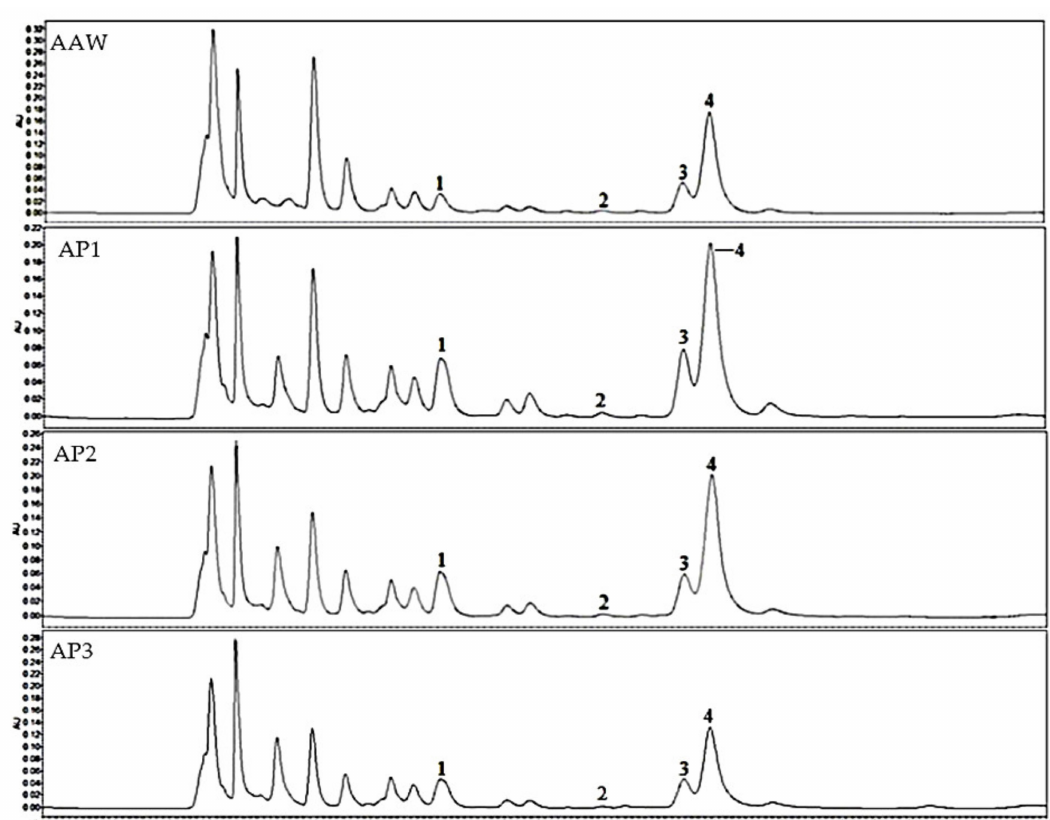
Figure 1. HPLC chromatogram of the apple acetone extracts. Analytes determined at λ = 205 nm: 1—corosolic acid; 2—betulinic acid; 3—oleanolic acid; 4—ursolic